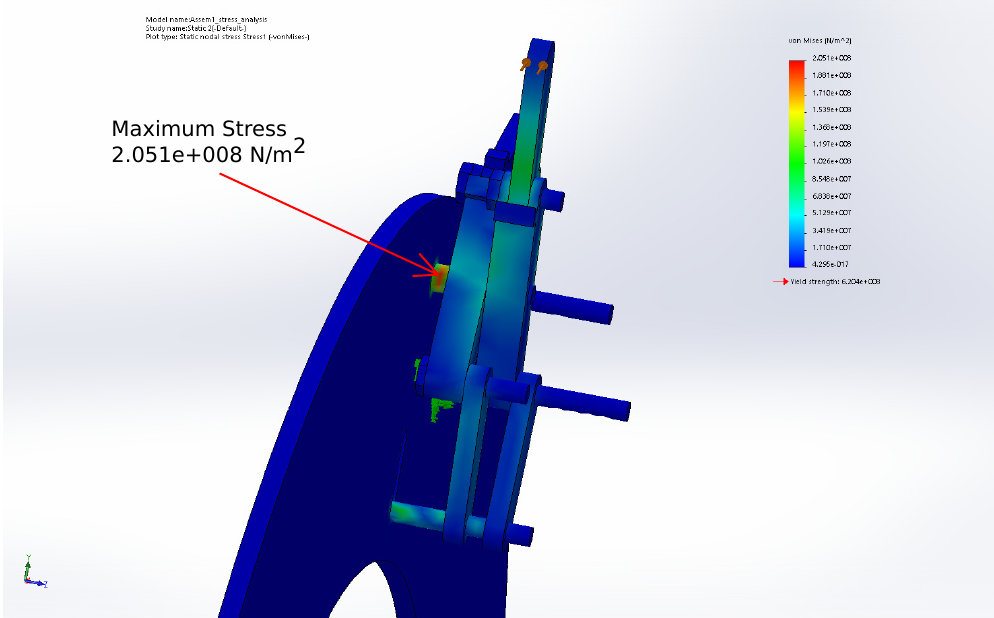
Figure 15. Von-Mises stress on chain 1 due to external loading (View